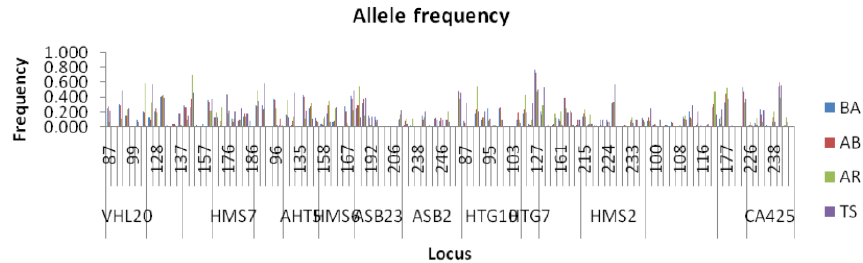
Figure 1. Allelic frequencies by population with graph over